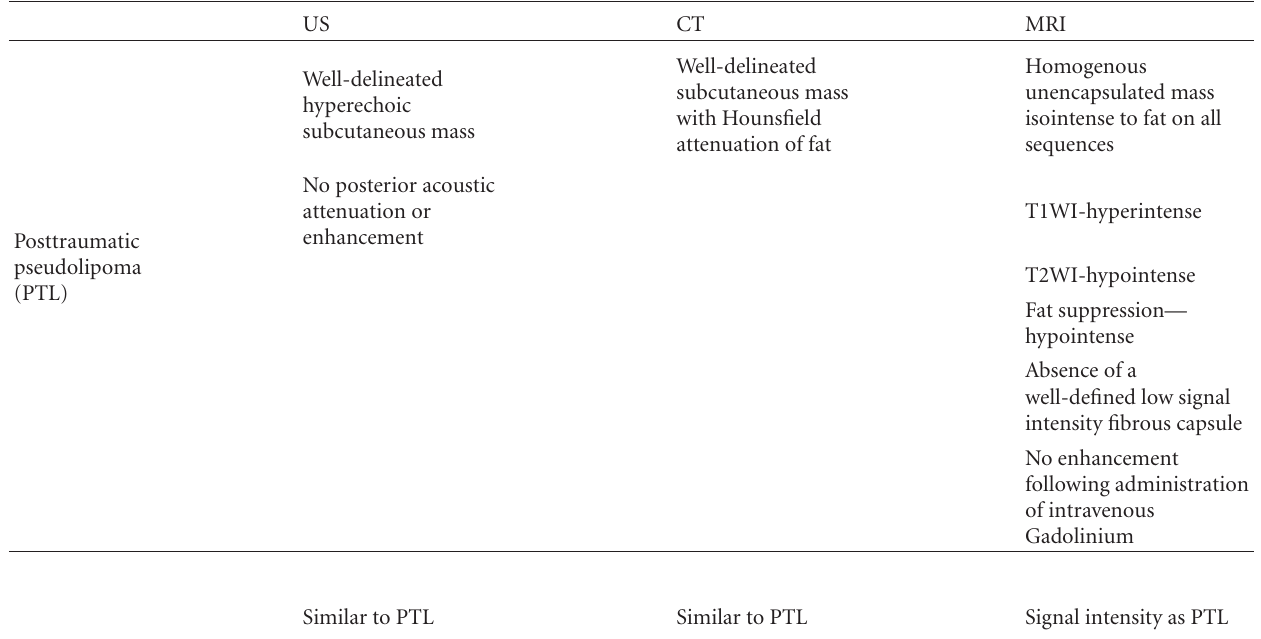
Table 2: Typical imaging features of PTL, lipoma, and